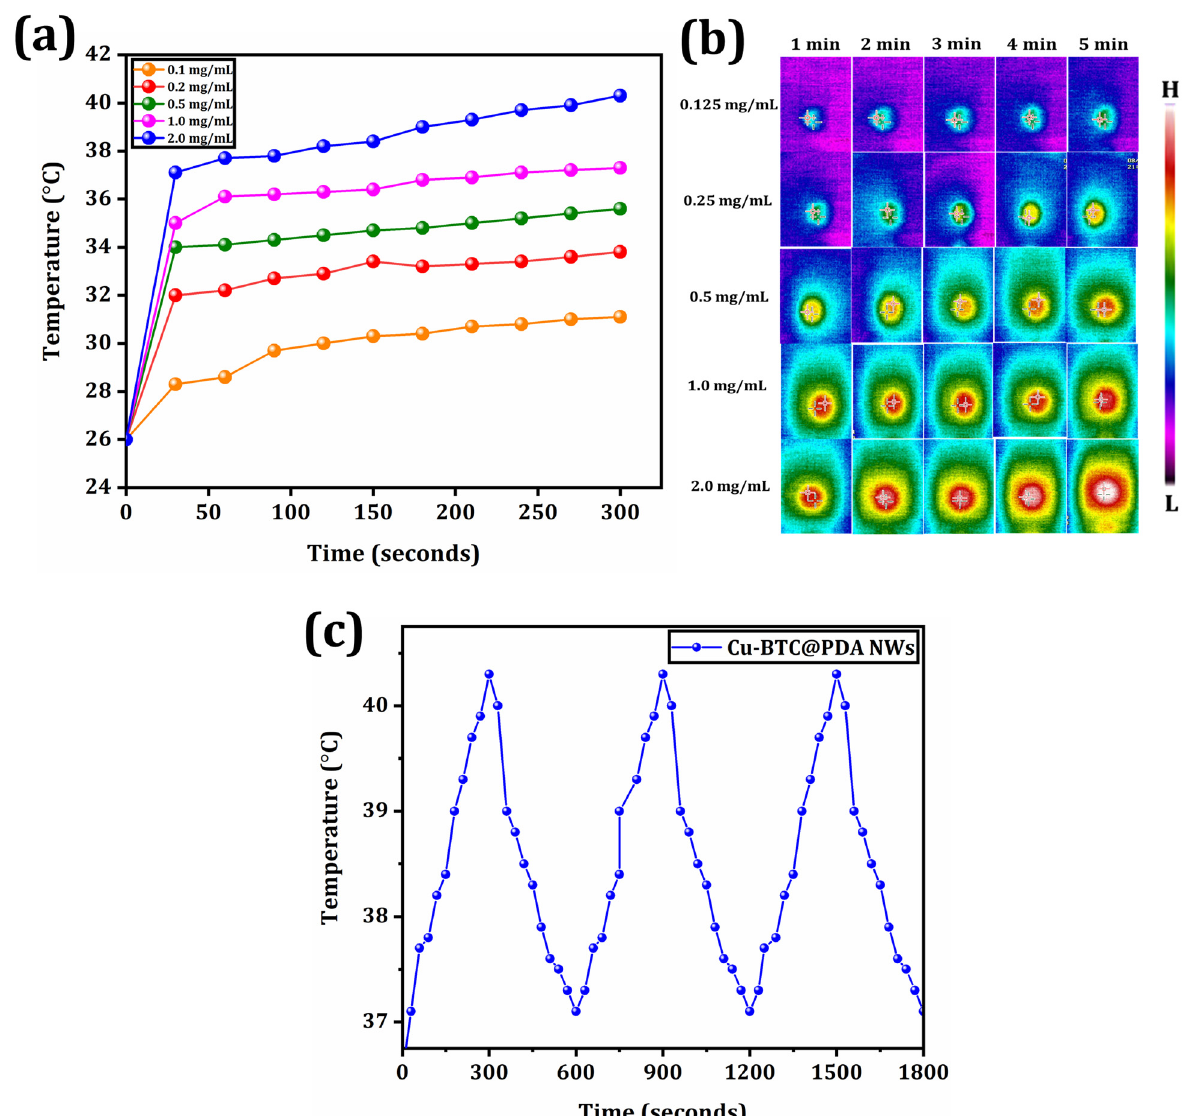
Figure 4. ( a ) Temperature elevation of Cu-BTC@PDA NWs. ( b ) IR Thermal images. ( c ) Photothermal 2 stability (808 nm/1W/cm 2 ). stability (808 nm/1W/cm